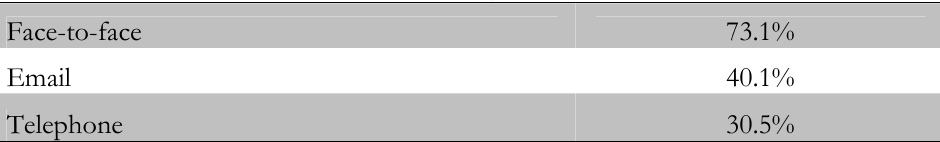
Table 6. Mobilized through friends or relatives